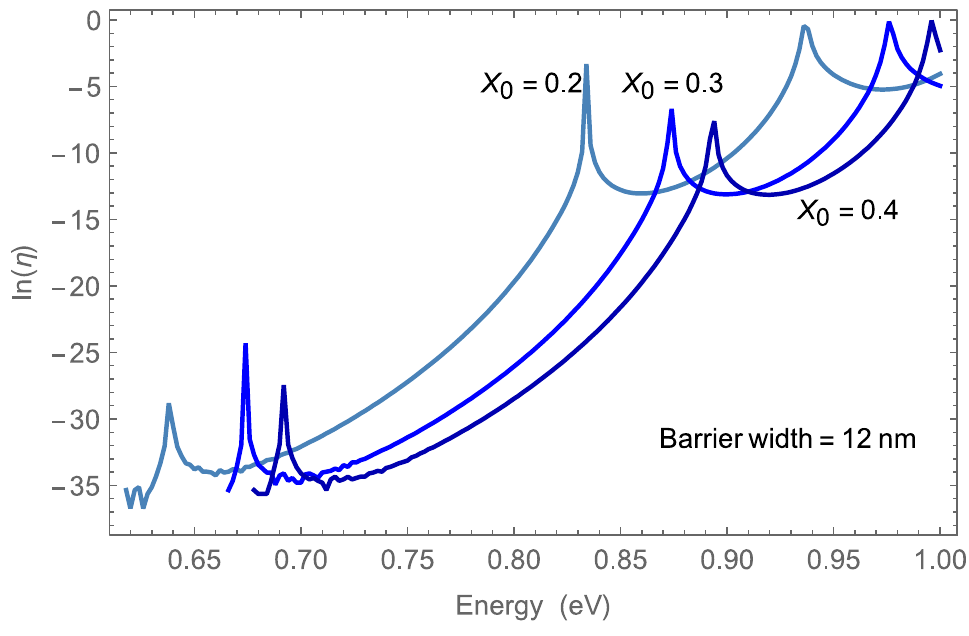
Figure 8. Logarithm of the transmission coefficient for electrons as a function of energy for the double-barrier In x Ga 1 − x N/GaN parabolic quantum well structure with various x 0 at an applied bias of 0.8 V, and barrier width 12 nm.